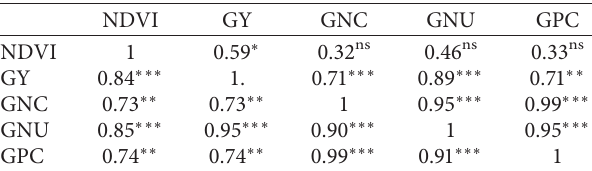
Table 7: Pearson’s correlation coefficients for NDVI, grain yield, N-content, N-uptake, and grain protein content of maize grown with two tillage methods, two cropping systems, and four nitrogen levels at Hawassa Zuria (upper right side) and Meskan (lower left